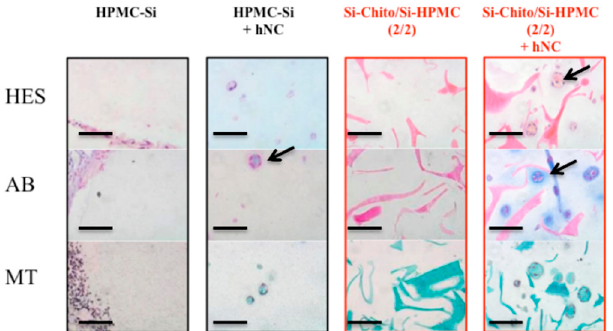
Figure 5. hCN were cultured and implanted with the Si-HPMC/Si-chitosan (2/2, % wt/v) hydrogel into subcutaneous pockets of nude mice (right column) and in Si-HPMC hydrogel as a positive control (2nd column). Si-HPMC (2% wt/v) and Si-HPMC/Si-chitosan (2/2, % wt/v) hydrogel without cells were used as negative control. 1 million cells/mL were associated with hydrogel. Hematoxylin–eosin-safran (HES) staining, (1st row) Alcian blue (AB) staining (2nd row) and Masson’s trichrome (MT) staining (3rd row) were performed for all conditions . Scale bar: 100 µm.